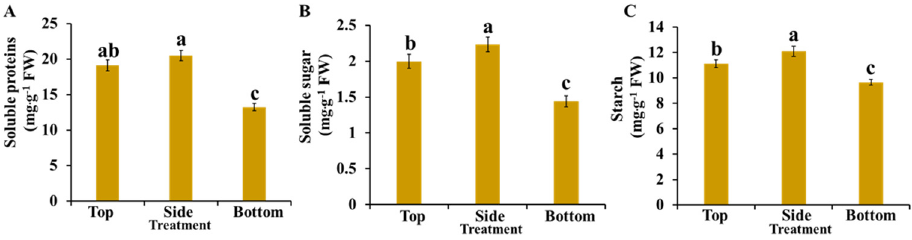
Figure 7. Changes in the contents of soluble proteins ( A ) and carbohydrates ( B , C ) of strawberry ‘Sulhyang’ plants as affected by the lighting direction after 45 days of cultivation. Vertical bars indicate the means ± standard error ( n = 6). Different lowercase letters indicate significant separations within treatments by Duncan’s multiple range test at p ≤ 0.05.